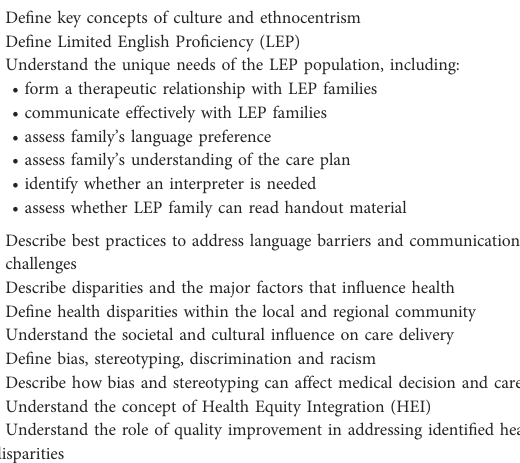
TABLE 3 Leaders in Health Equity (LHE) learning